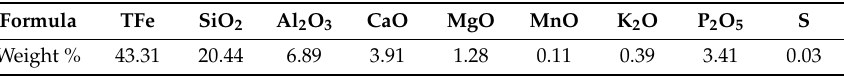
Table 1. Raw ore chemical composition (wt %).